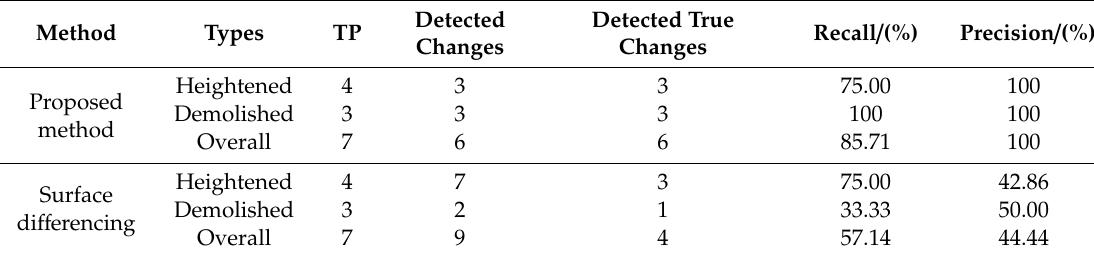
Table 6. Object-based change detection results of Enschede